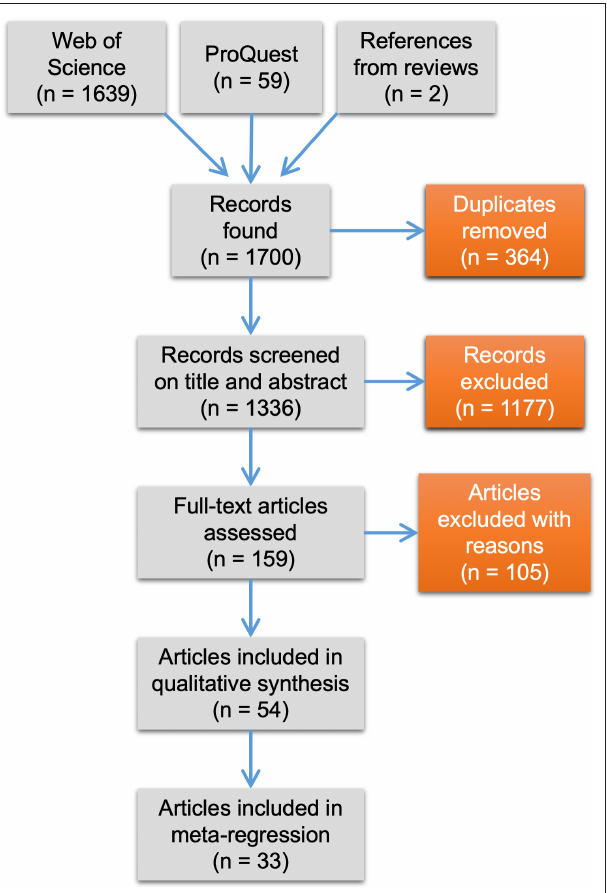
FIGURE 1 | PRISMA flow diagram showing number of articles retrieved from the literature search and retained or excluded during the study selection